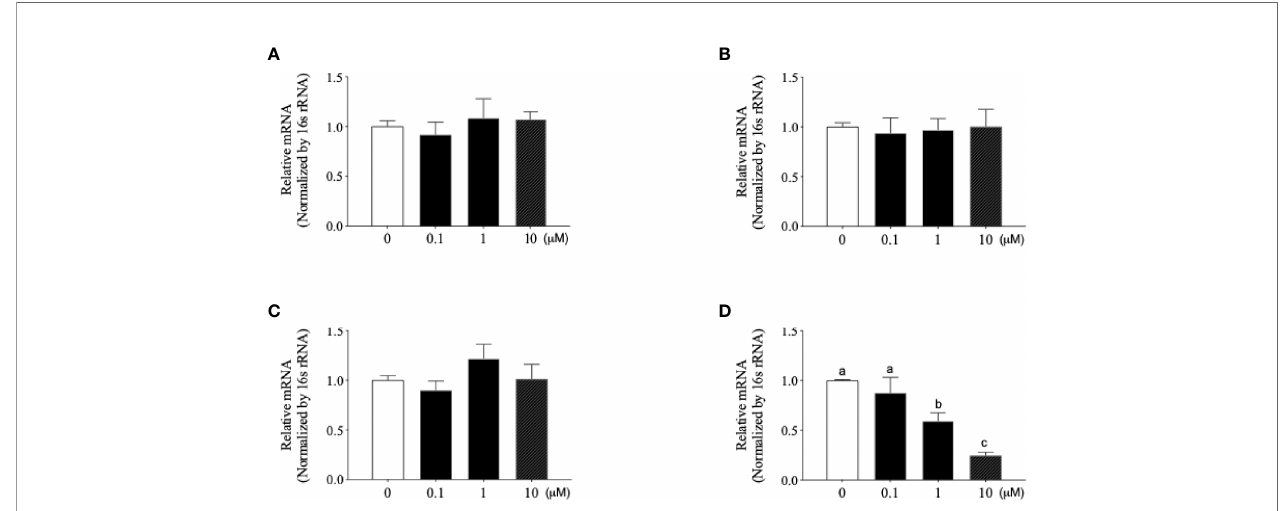
FIGURE 4 | Newly designed Mce4a antisense locked nucleic acid (LNA) gapmer (Mce4a-ASO) speci fi cally downregulates the expression of Mce4a in Mycobacterium tuberculosis ( Mtb ). Mtb was incubated with various concentrations (0.1 – 10 µM) of Mce4a-ASO for 48 h. Gene expression was measured by real-time PCR using